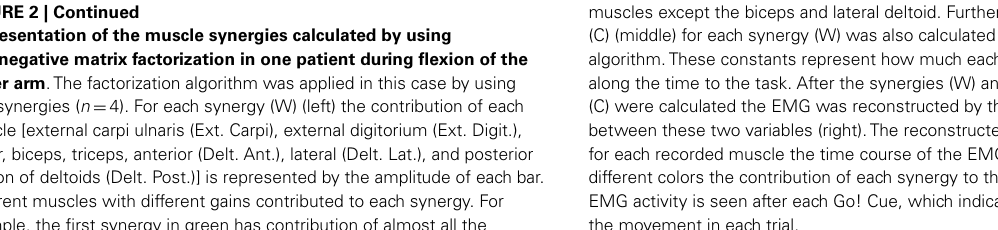
muscles except the biceps and lateral deltoid. Furthermore, a time constant (C) (middle) for each synergy (W) was also calculated by the factorization algorithm.These constants represent how much each synergy contributes along the time to the task. After the synergies (W) and the time constants (C) were calculated the EMG was reconstructed by the sum of the products between these two variables (right).The reconstructed EMG [ m ( t )] shows